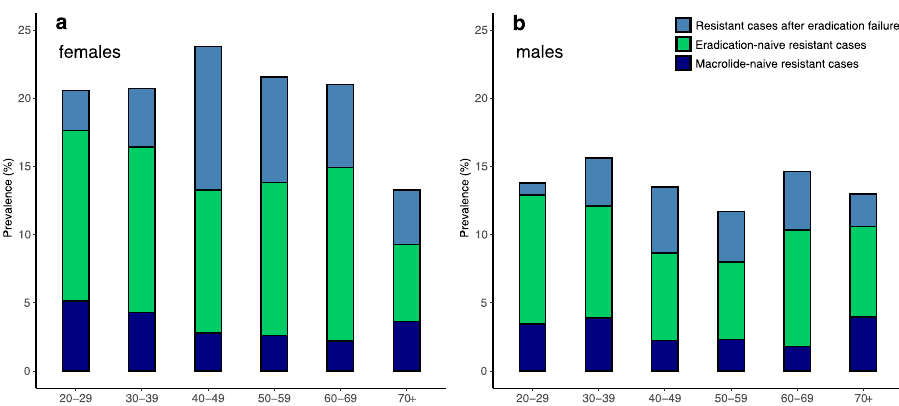
Fig. 2 Prevalence of Helicobacter pylori clarithromycin resistance in adults by age group (relative to the total cohort). a Cla-resistance was diagnosed in 530 cases out of the 2675 adult female patients. Treatment-related subcohorts (resistant cases after eradication failure/eradication-naive resistant cases/ macrolide-naive resistant cases) according to age groups: 20 – 29 years: 4/17/7, 30 – 39 years: 12/34/12, 40 – 49 years: 45/45/12, 50 – 59 years: 53/77/18, 60 – 69 years: 33/69/12, 70 + years: 24/34/22. b Cla-resistance was diagnosed in 272 cases out of the 2017 adult male patients. Treatment-related subcohorts (resistant cases after eradication failure/eradication-naive resistant cases/macrolide-naive resistant cases) according to age groups: 20 – 29